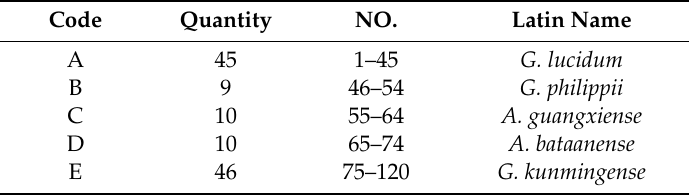
Table 5. Information of the mushroom